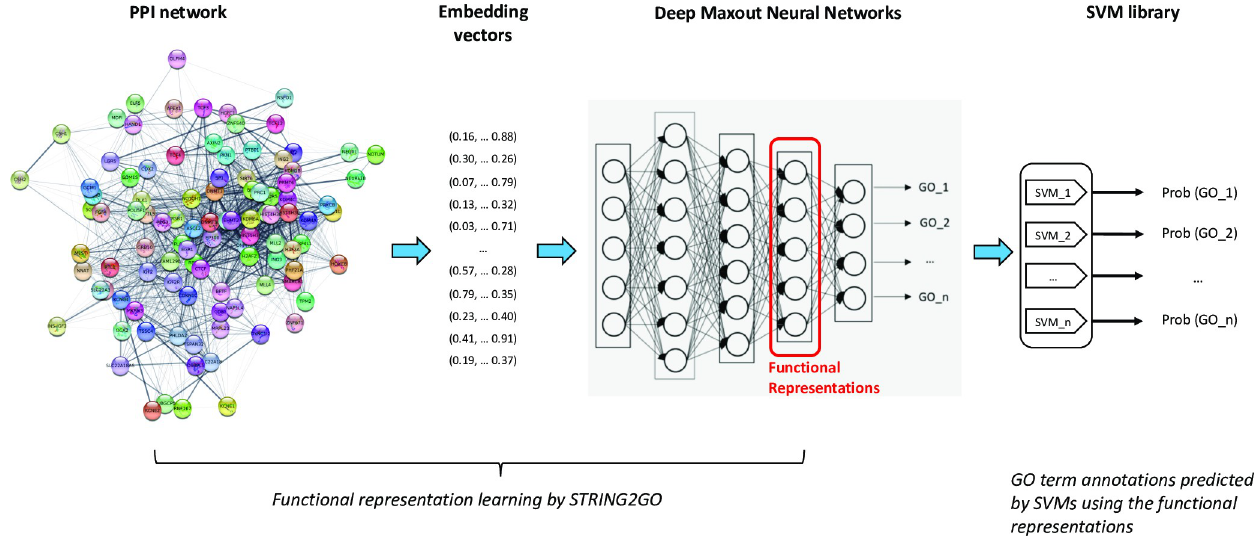
Fig 1. Flow-chart of STRING2GO-based protein function prediction